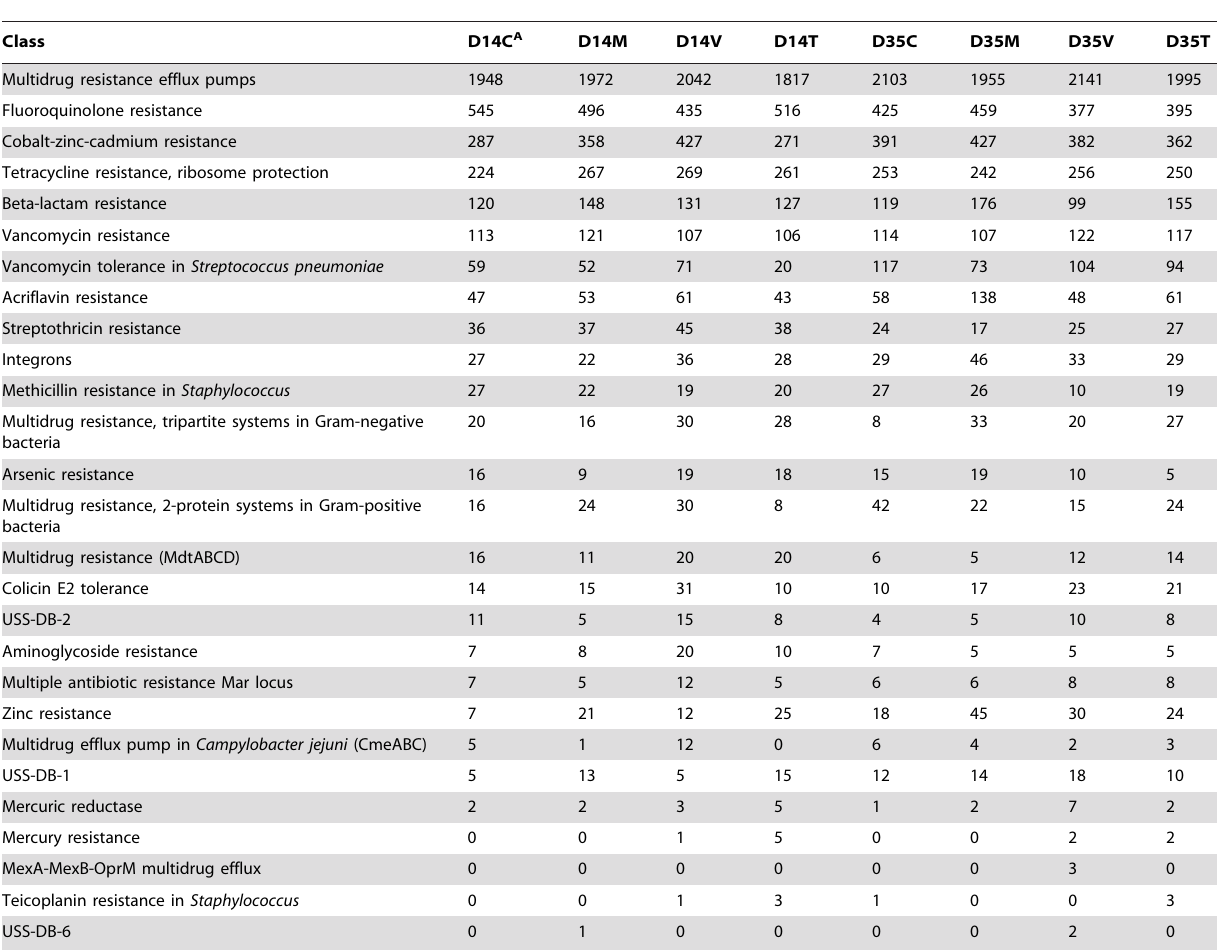
Table 3. Summary of resistance-associated subsystems among shotgun metagenomic